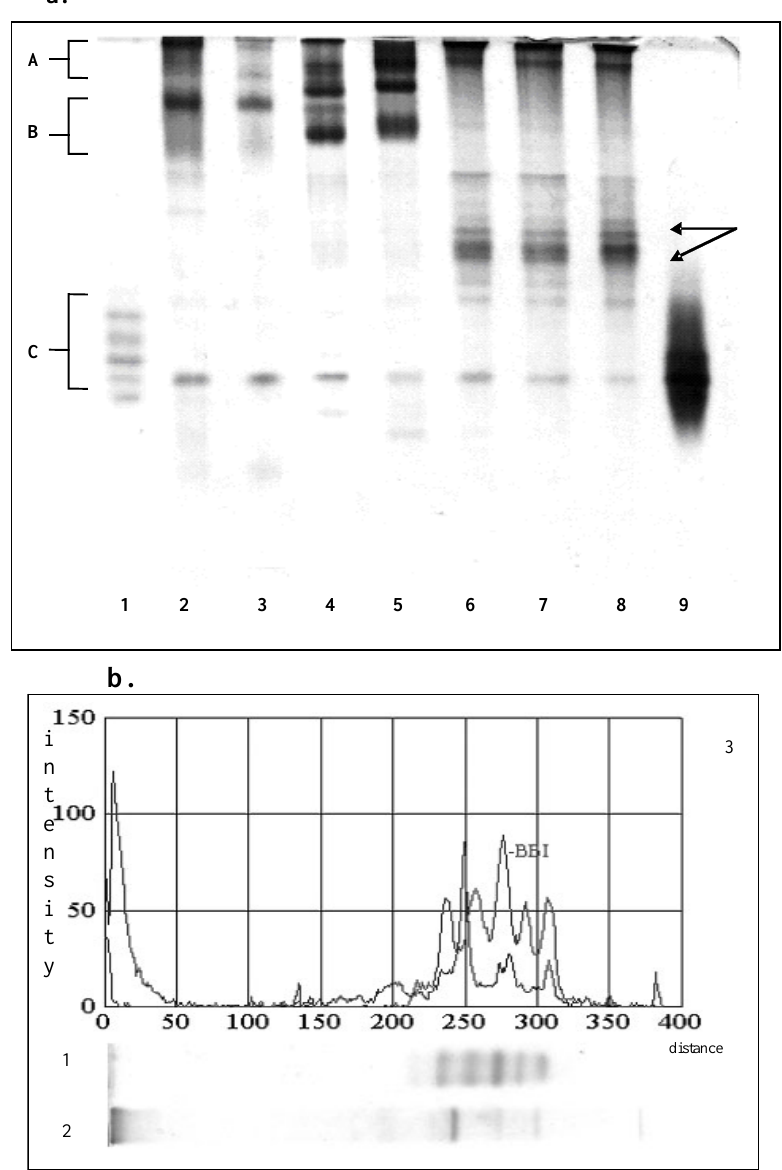
Figure 1 . PAGE-analysis of the extractable soluble proteins of soy flour, traditional and modified concentrates.(a) 1. Standard of Bowman-Birk inhibitor, 2. Raw soy flour, 3. Traditional concentrate,4. heat treated sample, 5. Functional concentrate, 6, 7, 8. Samples modified with trypsin for 30, 60, 90 minutes, respectively; (b) 1.Bowman-Birk inhibitor, 2. Traditional concentrate modified with pepsin. 3. Densitometric analysis of BBI and pepsin-modified